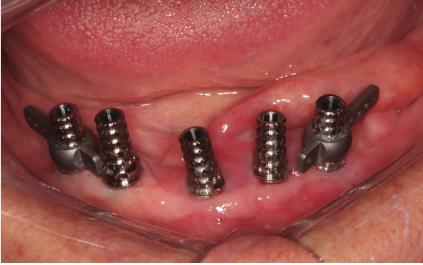
Figure 8: Installation of titanium cylinders and distal bars of cantilever extension system (implants 1 and 5).